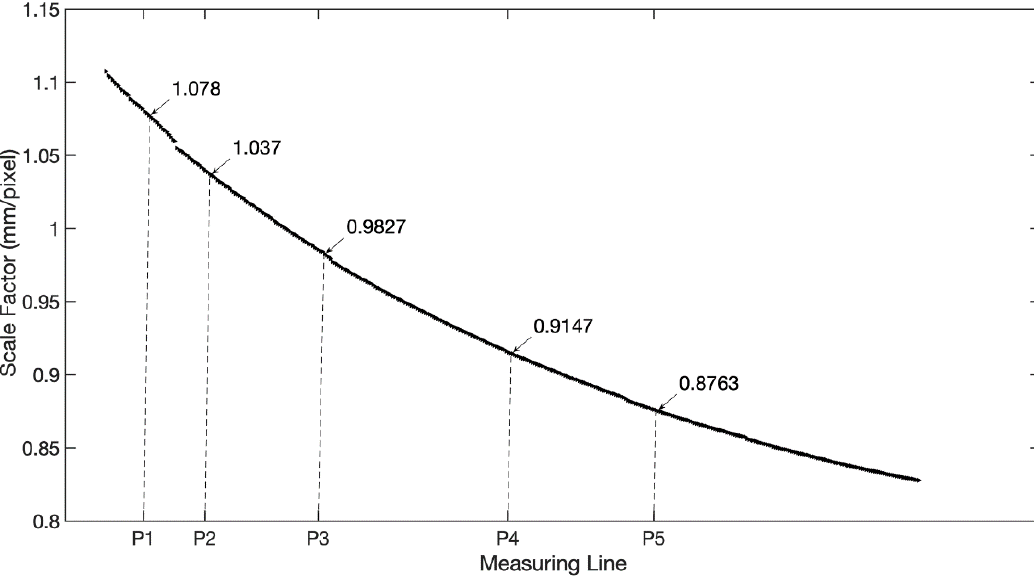
Figure 8. Full-field scale factors of the cantilever beam. During the experiment, five different weights, 1.0 kg, 3.0 kg, 3.5 kg, 4.0 kg, and 4.5 kg, were loaded and unloaded on the cantilever beam. The full-field deflection curves of the beam under the loading phase are shown in Figure 9a. In general, the full-field deflection curves of the beam are smooth, and the deflections at the free end vary notably and demonstrate to be proportional to the magnitudes of the loads. To assess the measurement accuracy, Figure 9b shows the deflections detected by the dial indicator and the results provided by the proposed technique at 11 loading stages. Table 1 summarizes the mean errors and standard deviations of all the loading stages. It can be seen from the table that the measurement accuracy can reach 0.085 mm for the